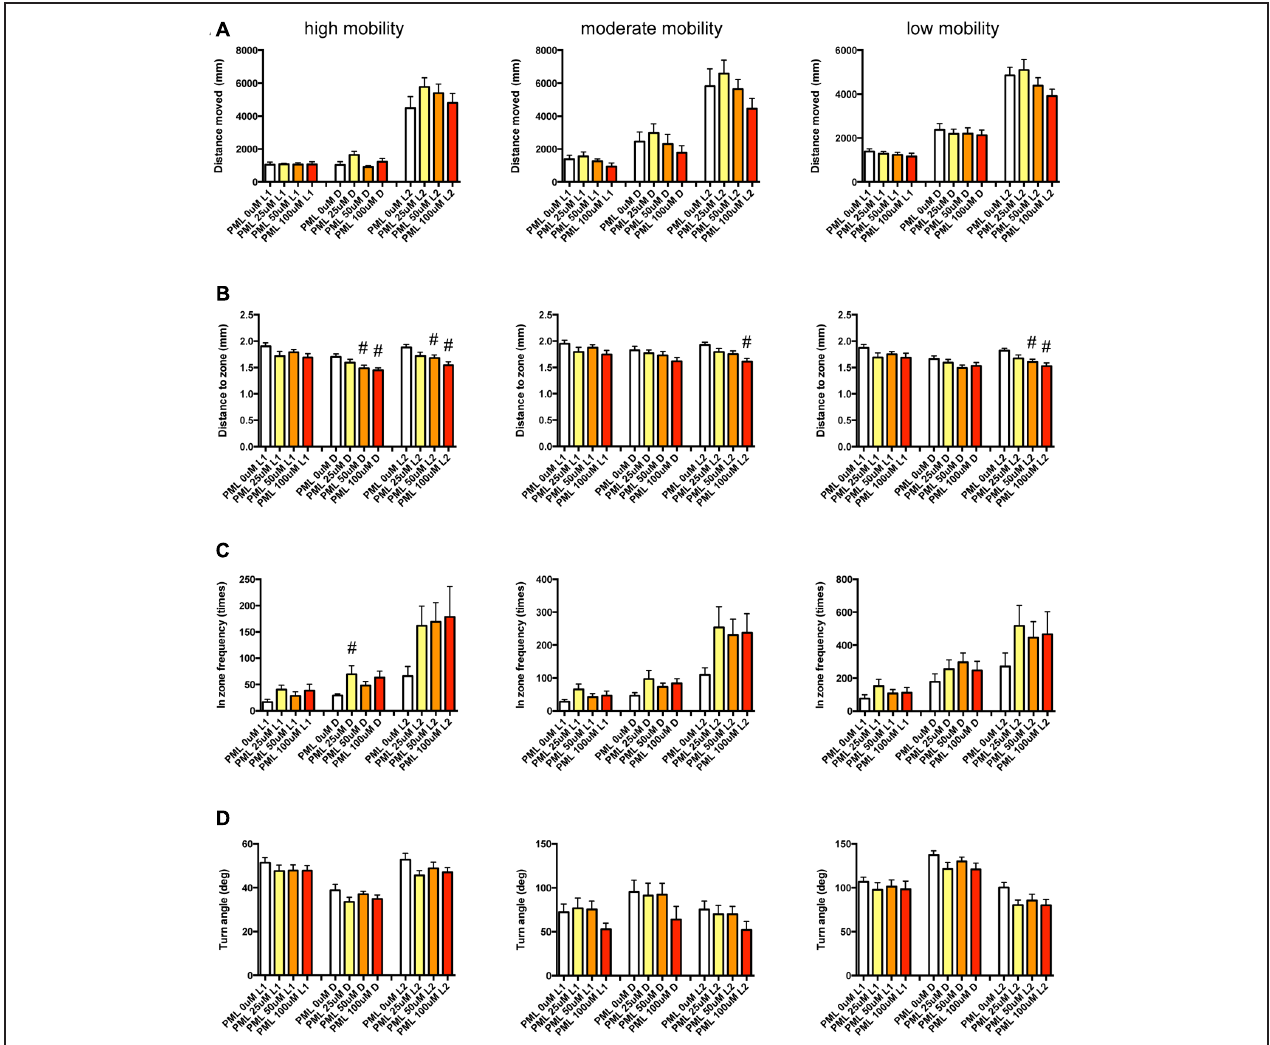
FIGURE 12 | Behavioral profiling of zebrafish treated with pemoline. The behavior of zebrafish treated with pemoline from 9 to 10 dpf were classified into three groups based on their mobility. Distance moved (A) , distance to zone (B) , in zone frequency (C) , and turn angle (D) at L1, D, and L2 periods are shown for each mobility classification. The data are represented as means with the standard error of mean. # p < 0.05 vs. 0 μ